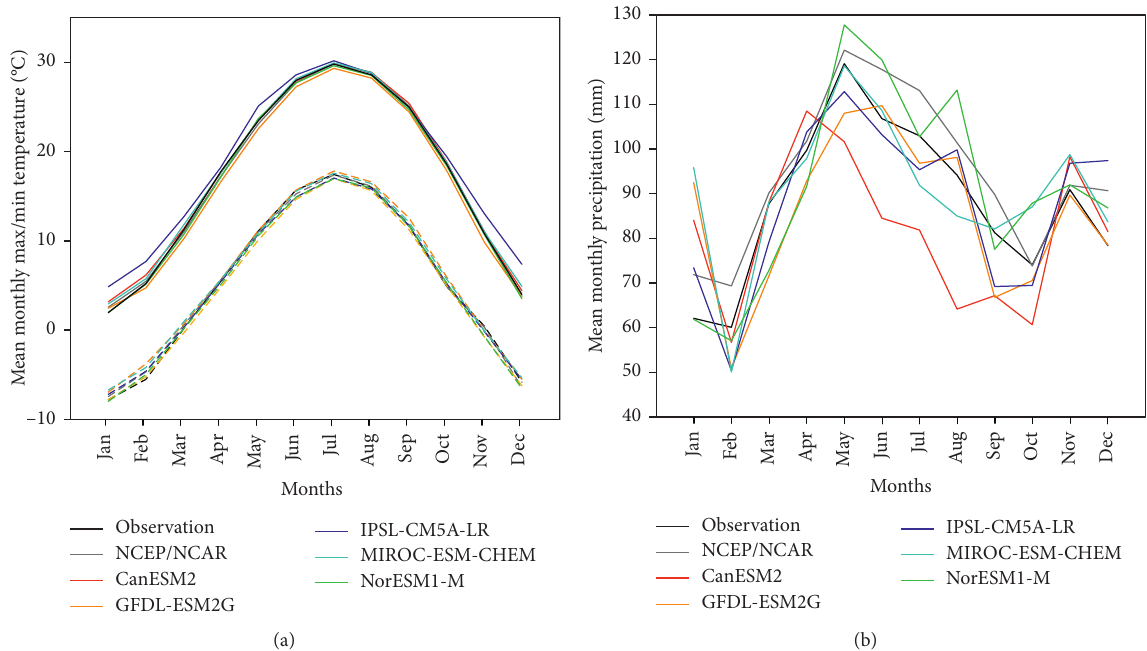
Figure 4: Annual cycle of mean monthly (a) maximum (solid lines) and minimum (dashed lines) temperatures and (b) precipitation averaged over the Wabash River Watershed for observation and downscaled from the NCEP/NCAR and from five GCMs during the period